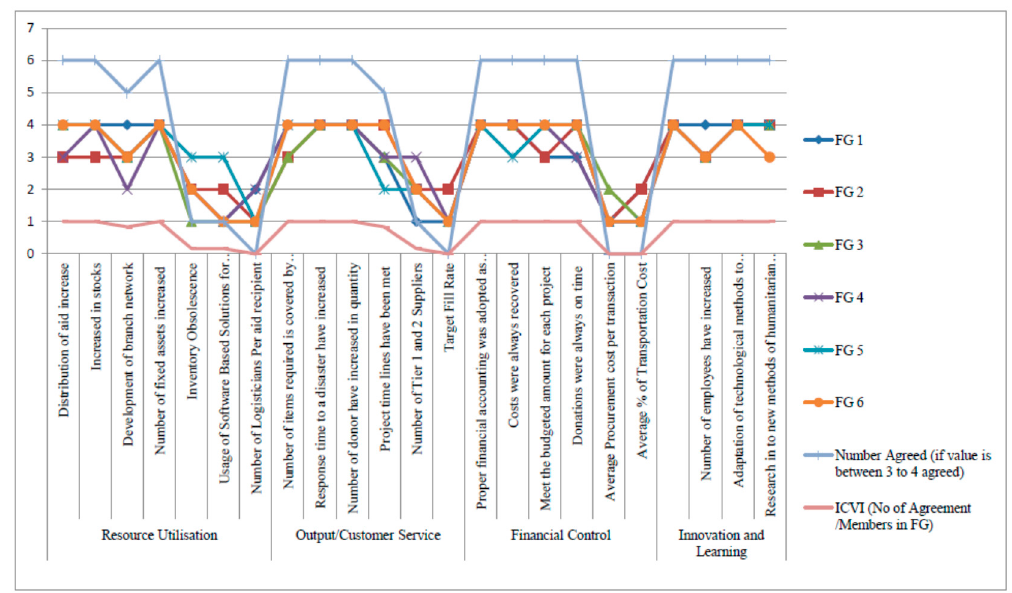
Figure 5. Individual Item Content Validity (ICVI) calculations of humanitarian organisations’ performance (Source: Survey data).